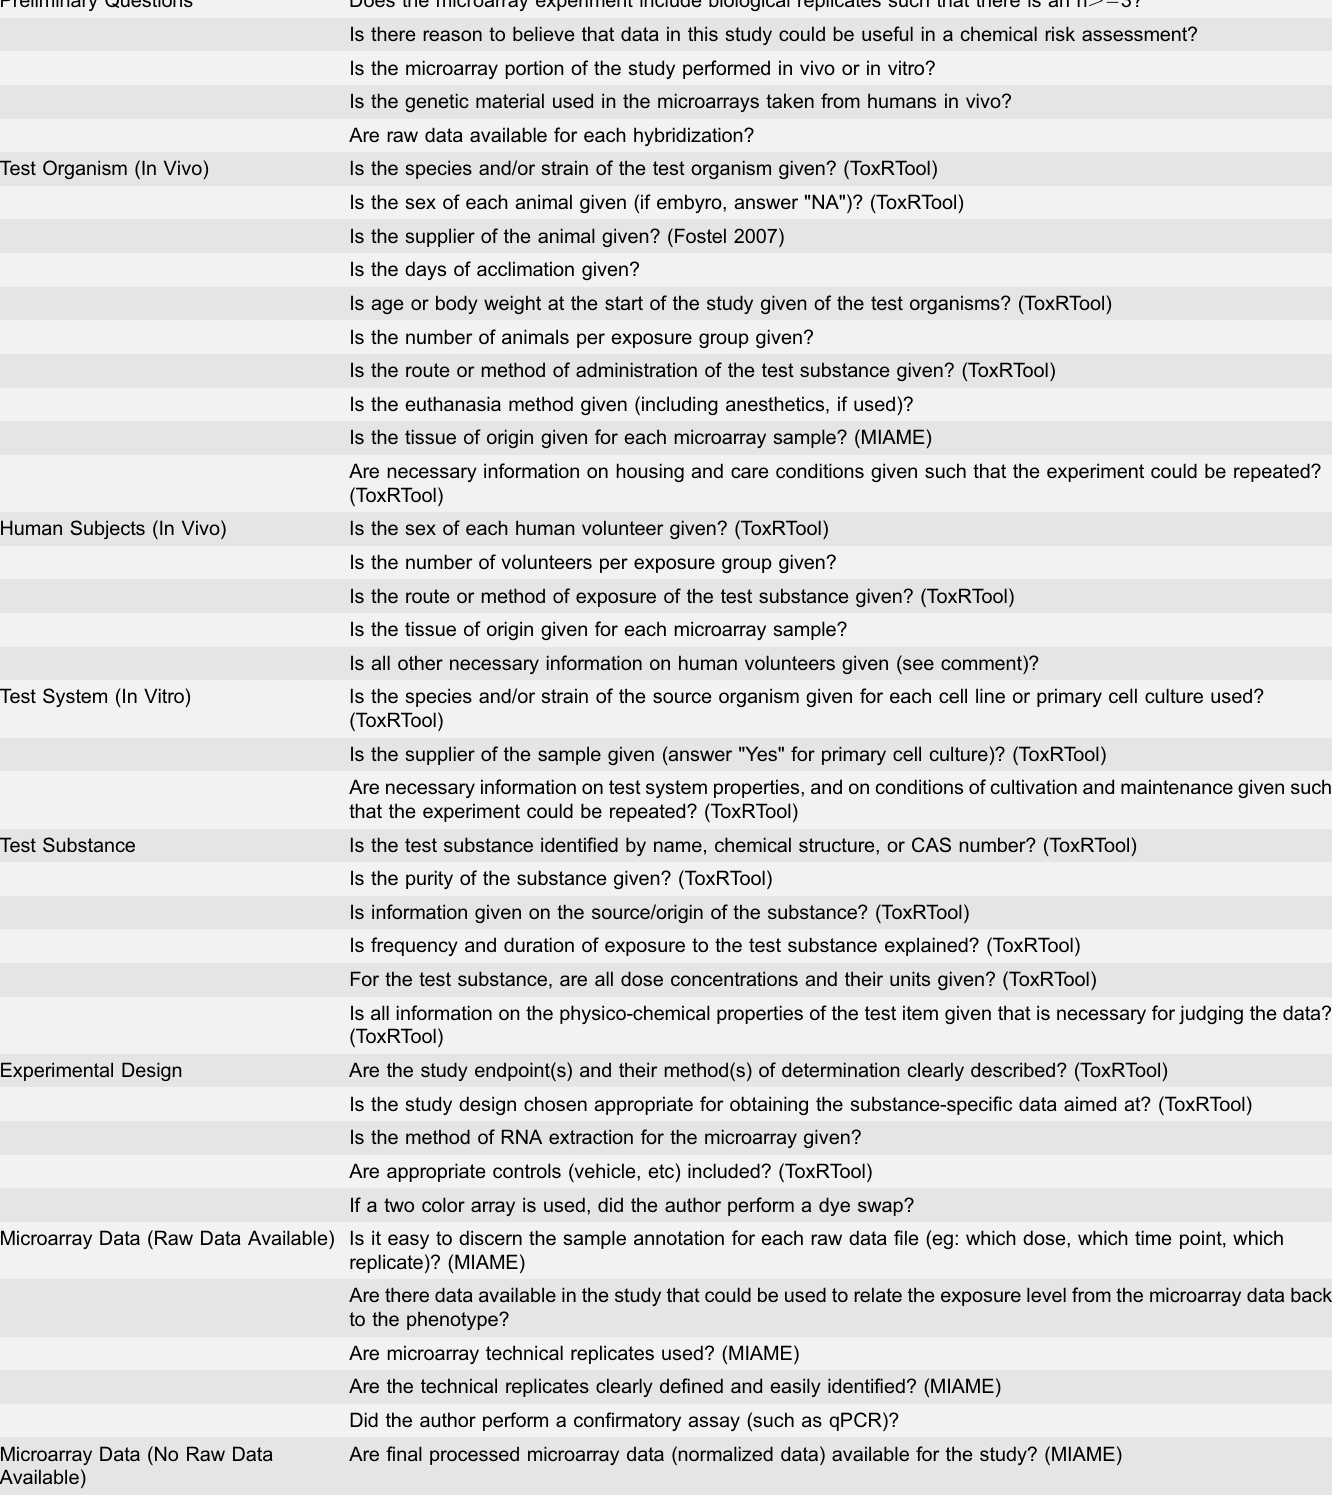
Table 5. The full questions included in the SOAR manual and the source of the question if it was taken from an existing publication. Preliminary